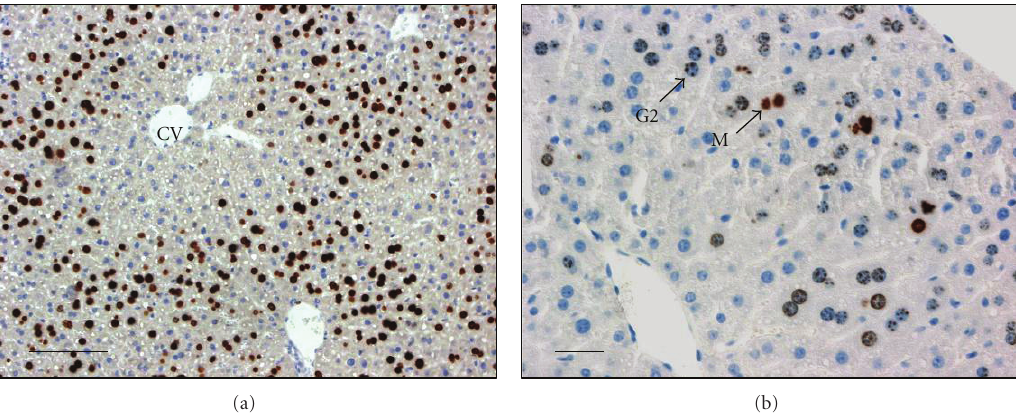
Figure 1: Sections of mouse liver evidencing detection of DNA replication and G2 phase. Mice were hepatectomized, injected at 46 hours after hepatectomy with BrdU, and killed 2 hours later (at 48 h). Livers were fixed for histological studies and detection of BrdU to visualize hepatocytes replicating DNA (a) or phosphohistone H3 (b) to detect cells in G2 phase. (a) This low magnification picture shows the detection of BrdU positive cells replicating DNA, illustrating that replicating hepatocytes are initially localized in the vicinity of the portal vein while around centrolobular veins (CV) only few hepatocytes replicate DNA at 48 h. (b) A higher magnification picture shows nuclei of hepatocytes reaching G2 phase (detection of phosphohistone H3 positive cells with punctuated nuclear signal: G2 and mitosis (M). Bars: 100 μ